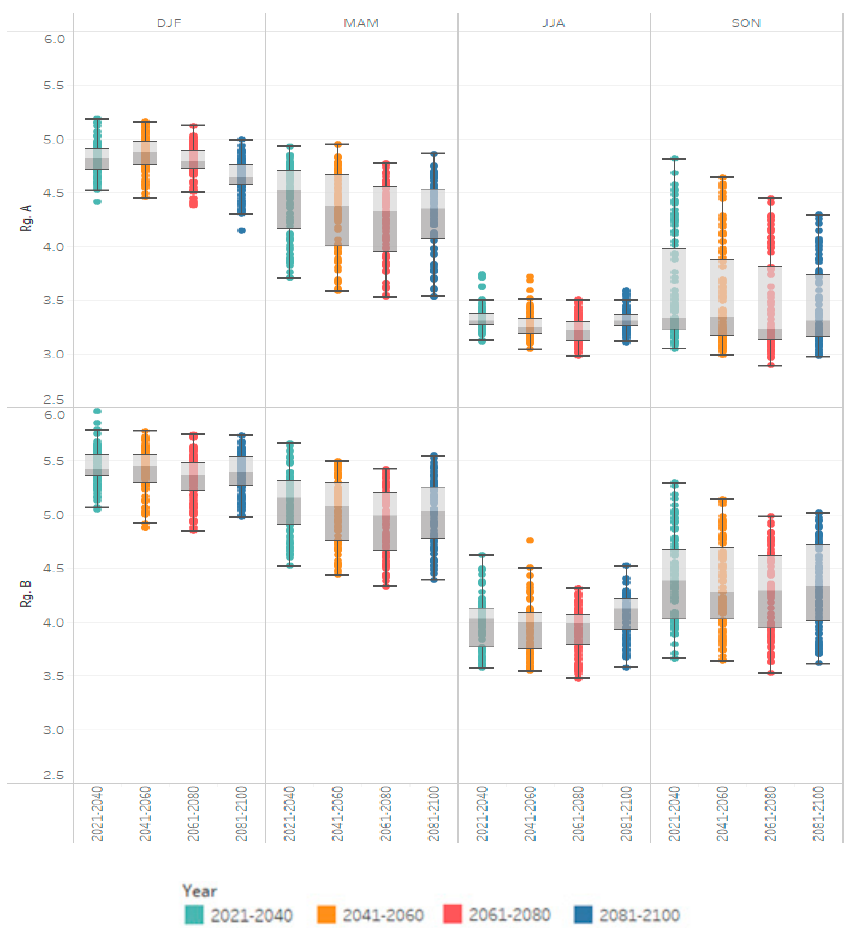
Figure A7. Boxplots of seasonal daily wind speed showing the spread including minimum values, maximum values, mean value, and quartiles for each time slice over Region A and Region